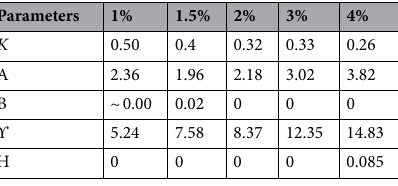
Table 3. Predicted values of cell mass concentration, substrate utilization, and product formation of Pantoea sp. BCCS 001 GH.